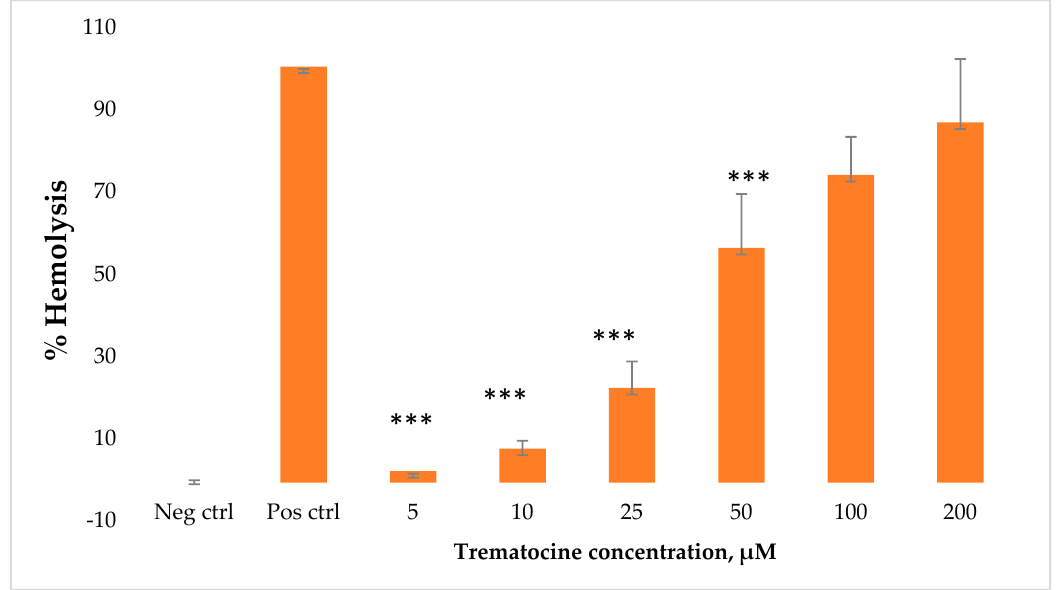
Figure 10. Hemolytic activity of Trematocine against rabbit erythrocytes. Six different concentrations have been tested. The values represent the mean + SD, and the asterisks indicate the significance level with respect to positive control (100% haemolysis): p < 0.01 *** .